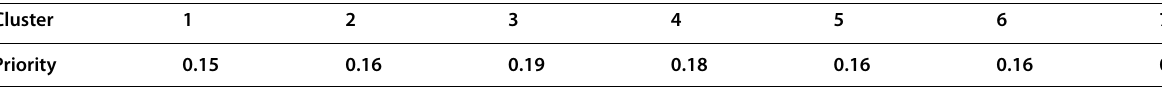
Table 1 Priorities of BRT public acceptance by